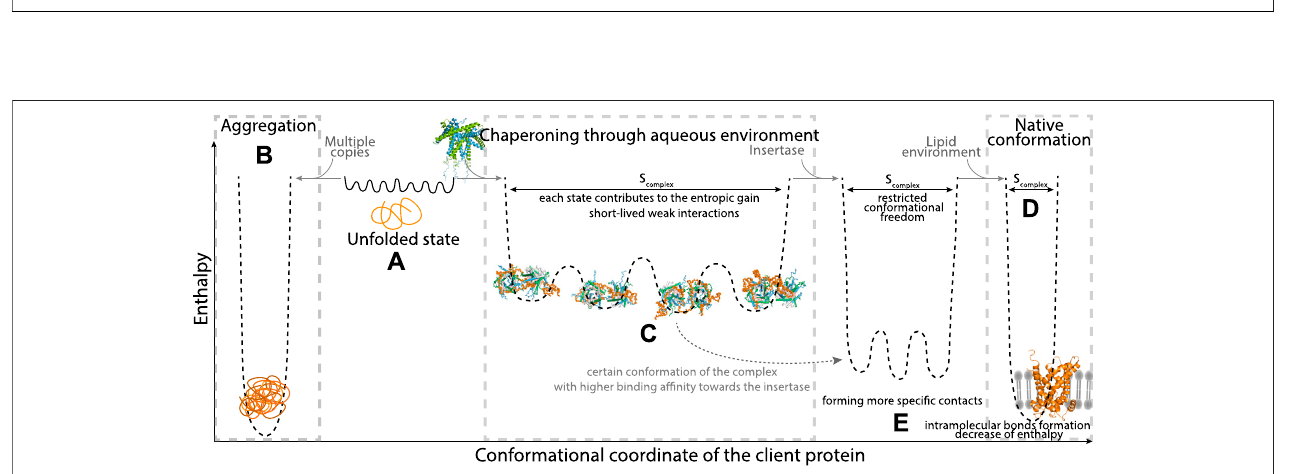
FIGURE 2 | Schematic view of the thermodynamic properties of a client protein exempli fi ed for a membrane-protein client (represented in orange). In the unfolded state of the client (A) , the polypeptide exists in an ensemble of multiple rapidly-interconverting conformations. Depending on the concentration of the client (presence of multiple copies) or the presence of a chaperone, the conformational landscape carries different energetic properties. Aggregation, shown on left (B) is enthalpically favourable due to multiple intra- and inter-molecular hydrophobic interactions. In the presence of a dedicated chaperone, shown in the middle (C) , the chaperone and clientform favorableinteractions(enthalpiccontribution),and astheclient generallystayshighlydynamicthere isno(orlittle)entropic cost,i.e.,theentropy(S complex ) remains large, comparable to the unfolded state shown in section A of this fi gure. For the membrane-protein clients, the pathway to the fully folded state (D) involves engaging with an insertase, which promotes folding of the client (E) . Certain conformations out of the complex ensemble may have higher af fi nity towards the insertase. The interaction of client and insertase may lead to a step-wise dissociation of the client from the chaperone and formation of more speci fi c contacts with the insertase. The lower conformational entropy (S complex ) may be compensated by favorable enthalpic interaction, or entropy gain from release of structured water molecules.